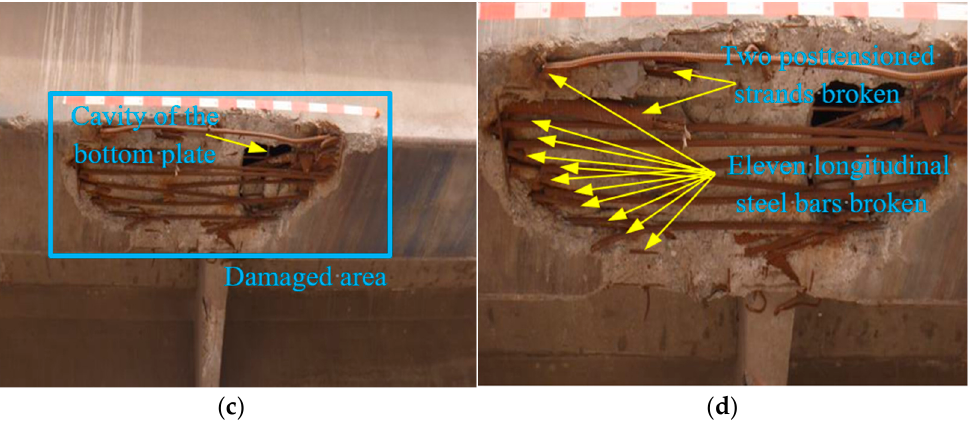
Figure 2. Modes of damage at the bottom of box girders. ( a ) Damaged area of the #4-2 girder; ( b ) Steel bars and pretensioned strands broken in the #4-2 girder; ( c ) Damaged area of the #3-2 girder ( d ) Steel bars and pretensioned strands broken in the #3-2 girder.